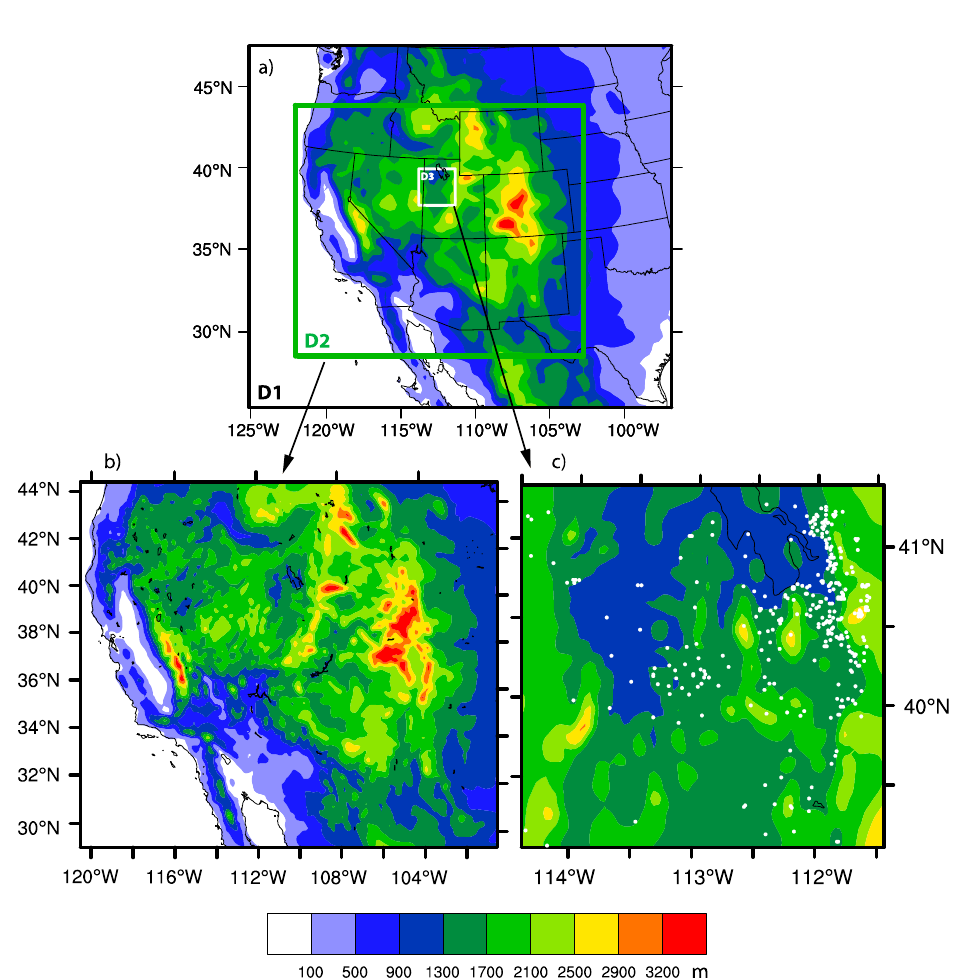
Figure 1. Model topography of ( a ) Domain 1, ( b ) Domain 2 and ( c ) Domain 3 and surface stations (white dots) in Domain 3 ( c ). The area within the green rectangle in ( a ) is Domain 2 (D2), and the area within the white rectangle is Domain 3 (D3). Topography (m above mean sea level) is shaded.